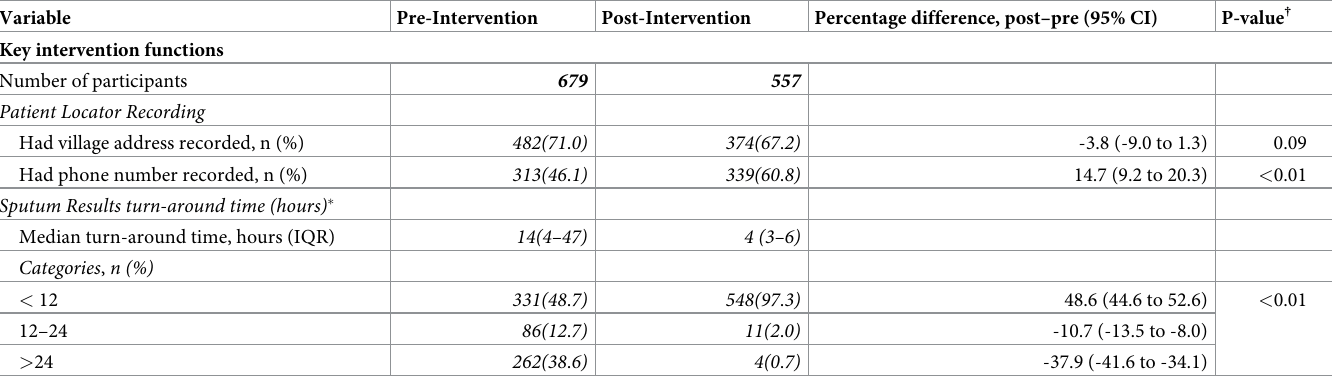
Table 2. Percentage differences in key intervention functions pre and post